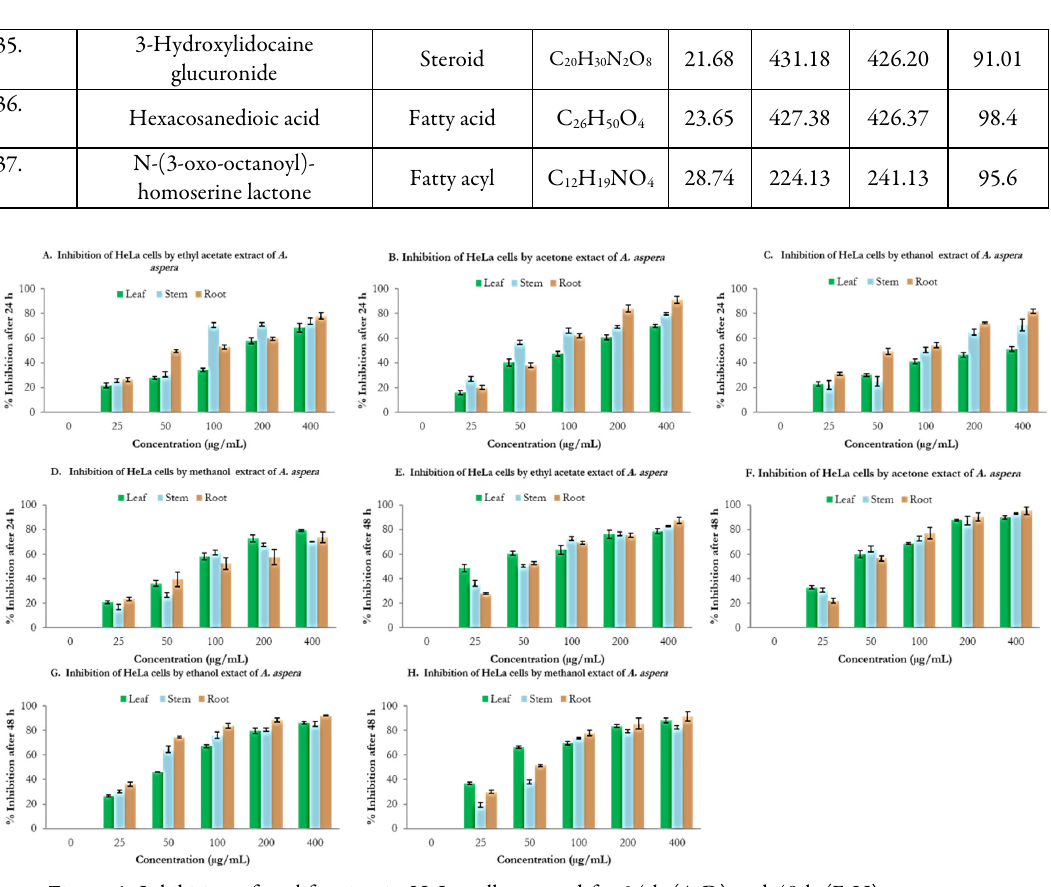
Figure 1. Inhibition of proliferation in HeLa cells exposed for 24 h (A-D) and 48 h (E-H) to extracts